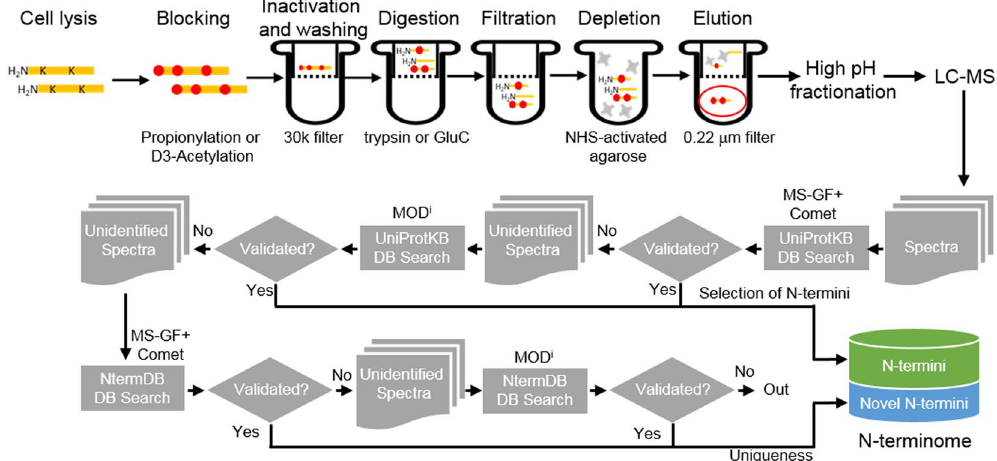
Figure 1. Outline of the Nrich method and the N-terminome discovery scheme. Proteins are labeled by D6- acetic anhydride or propionic anhydride to distinguish endogenous N-terminal acetylation from